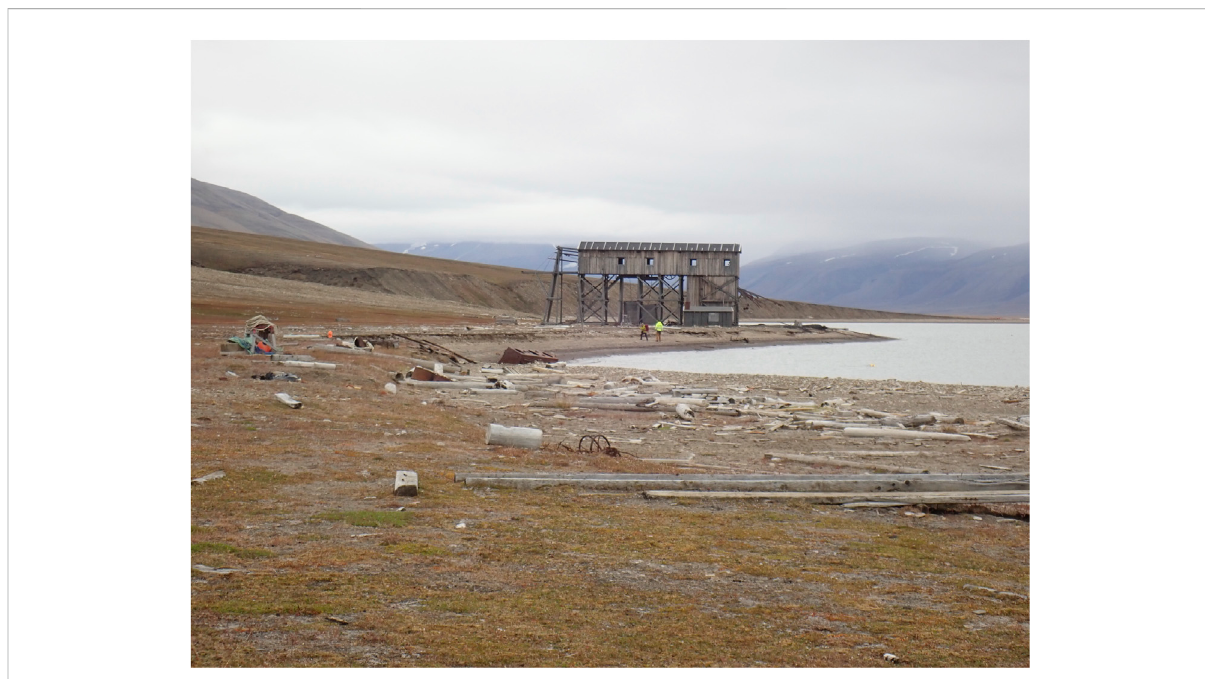
FIGURE 2 Hiorthhamn cableway station, Svalbard. Photo: Vibeke Vandrup Martens, NIKU